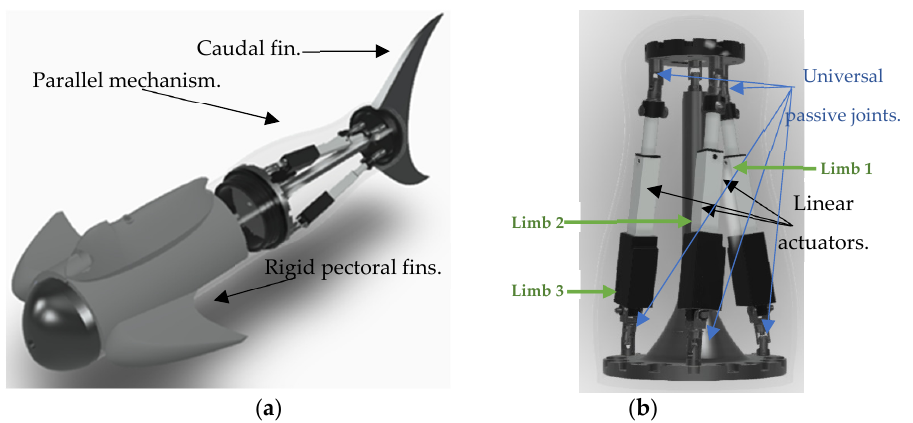
Figure 1. ( a ) BAUV design with attached caudal fin and body case ( b ) 3 DOF 3UCU ‐ 1S parallel mechanism employed on the propulsion system.